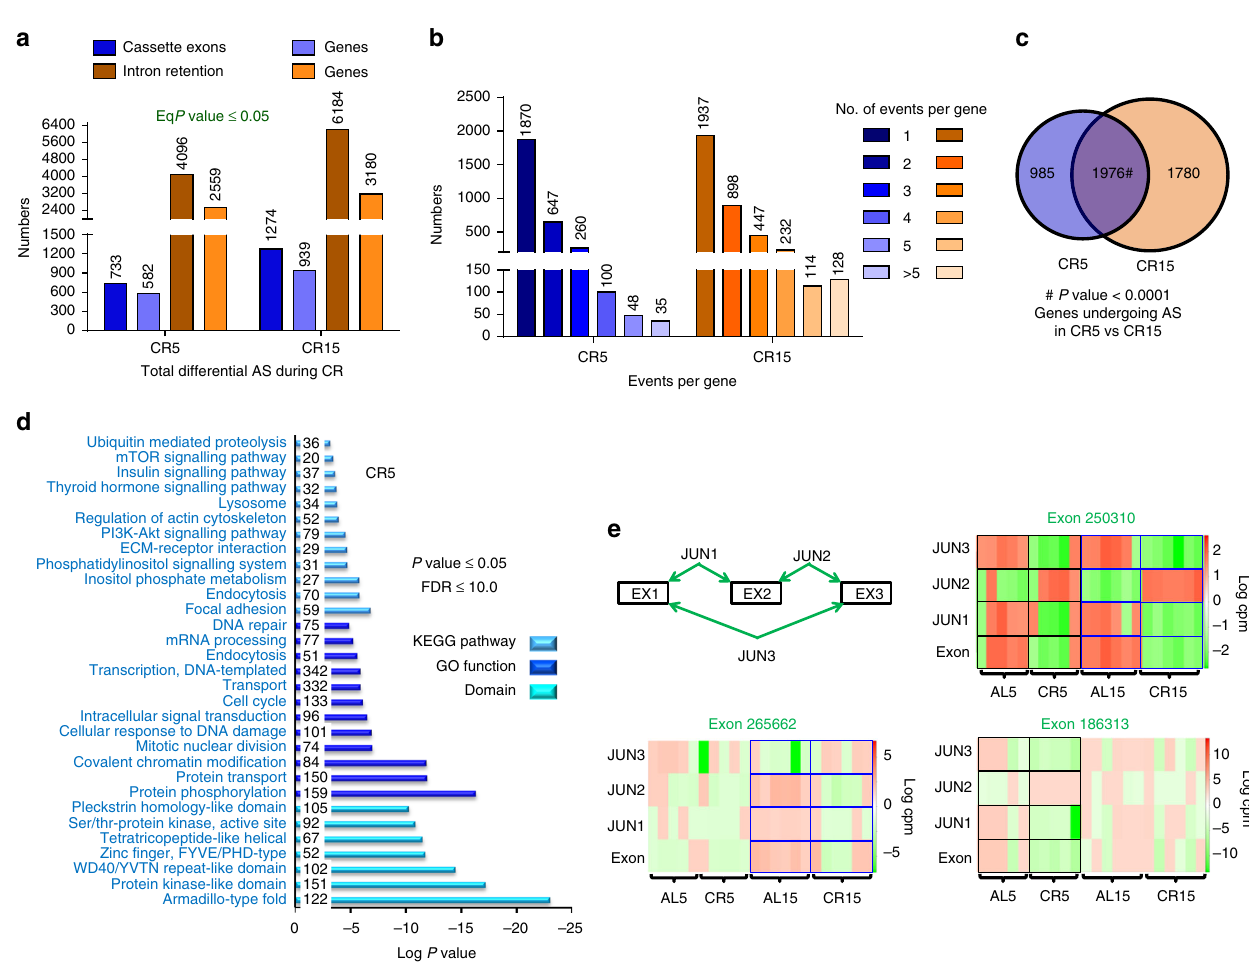
Fig. 2 Alternative splicing is increased in the hypothalamus of mice undergoing CR. a Alternative splicing events in mice on caloric restriction (CR) for 5 or 15 months (CR5 or CR15), as exhibited by the differential usage of cassette exons (CE; dark blue bars ) or by intron retention (IR; dark brown bars ). Spliced-in and spliced-out events are considered together to represent the total number of differential AS events (CE and IR only) during CR. The genes that these events correspond to are indicated in the lighter shades . Statistical test: Irwin – Hall P value summarization was used on each individual splicing event (details in the Methods section). Data are from fi ve (for CR5 or AL5) or six (for CR15 or AL15) biological replicates. b Distribution of the number of AS events (both CE and IR considered together) per gene in CR5 and CR15. c Signi fi cant overlap between genes undergoing AS during early (CR5) and late (CR15) phases of CR. P value determined by hypergeometric test. d KEGG pathway, Gene Ontology (GO) term enrichment and protein domains were determined by DAVID Functional Annotation tool using differentially AS genes in mice under CR diet for 5 months. The listed pathways have a P value ≤ 0.05 (Fisher Exact Test) and FDR < 10.0. The numbers within the blue bars represent genes detected in the category. e Representative images of AS involving cassette exons. For this, four terms were considered, reads mapping to the cassette exon (Exon), the fl anking junctions (JUN1, JUN2) and that of the skipping junction when the exon is not included (JUN3). Each box represents fi ve (for CR5 or AL5) or six (for CR15 or AL15) biological replicates in the RNA-seq experiments. In case of Exon 250310, the read counts mapping to the exon or the JUN3 were reciprocal in AL5 vs. CR5 as well as in AL15 vs. CR 15. On the other hand, the reciprocal relationship was observed either in case of early (Exon 186313) or late (Exon 265662) CR. cpm counts per